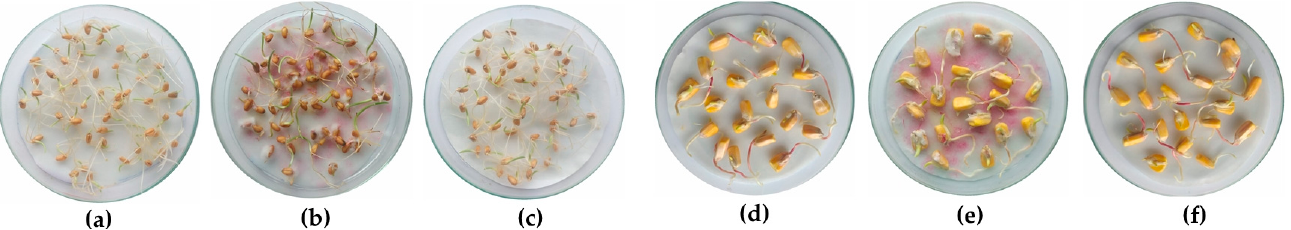
Figure 5. Germination tests: ( a ) wheat grains treated with T. gallica bark extract at a dose of 375 μ g·mL − 1 ; ( b ) positive control wheat grains (inoculated with F. graminearum and treated with distilled water); ( c ) wheat grains inoculated with F. graminearum and treated with T. gallica bark extract at a dose of 375 μ g·mL − 1 ; ( d ) maize grains treated with T. gallica bark extract at a dose of 375 μ g·mL − 1 ; ( e ) positive control maize grains (inoculated with F. graminearum and treated with distilled water); and ( f ) maize grains inoculated with F. graminearum and treated with T. gallica bark extract at a dose of 375 μ g·mL − 1 . Only one replicate per treatment is shown.